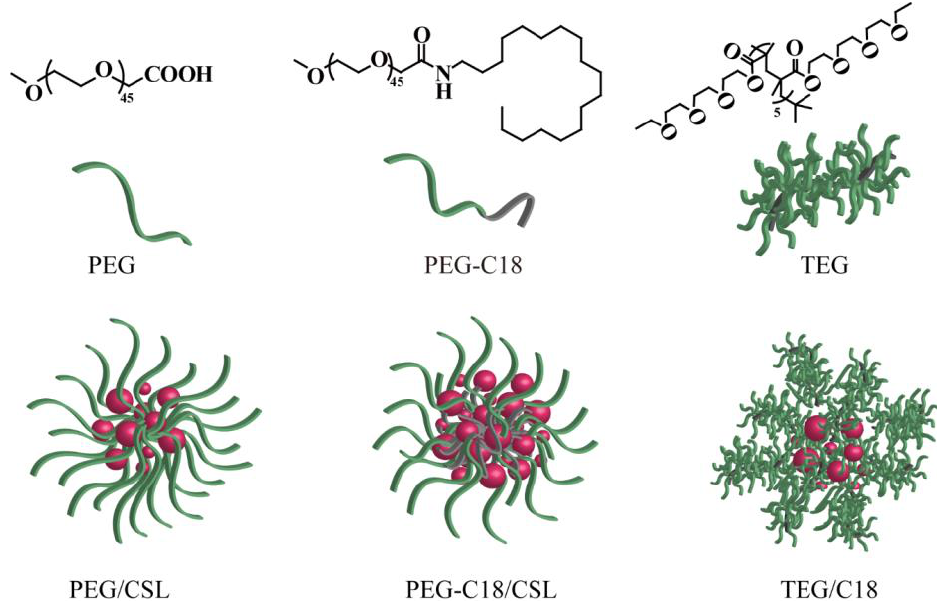
Figure 1. Structure of three nanocarriers and illustration of CSL-loaded